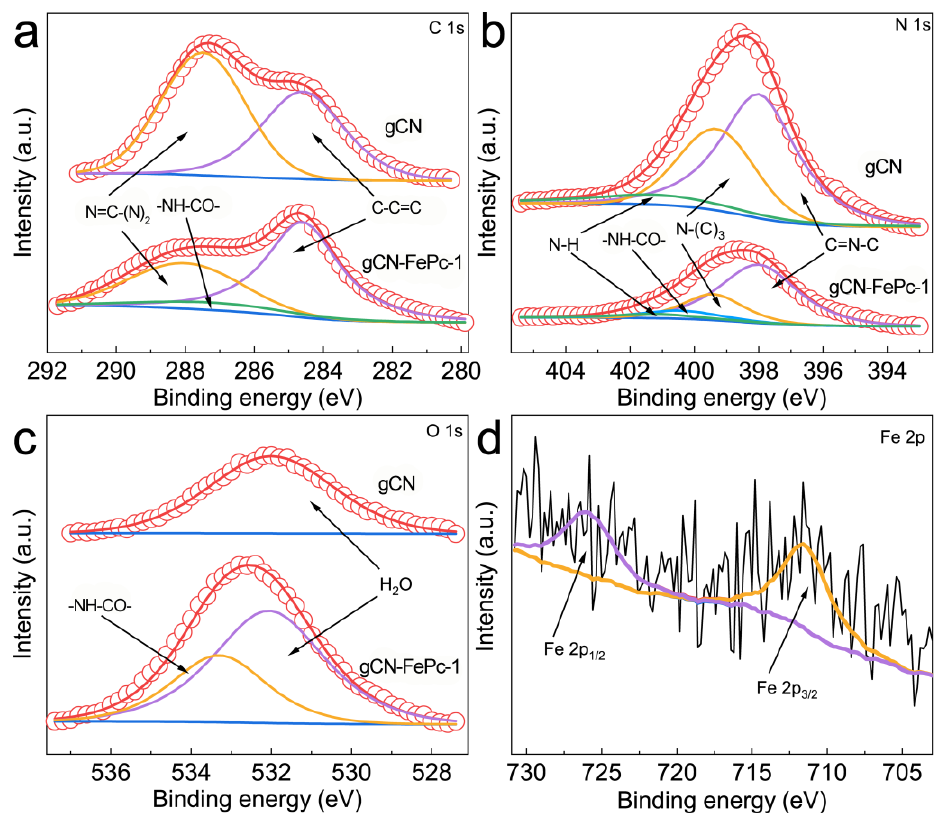
Figure 5. XPS spectra of gCN and gCN-FePc-1: C 1s ( a ), N 1s ( b ), O 1s ( c ), and Fe 2p ( d ).